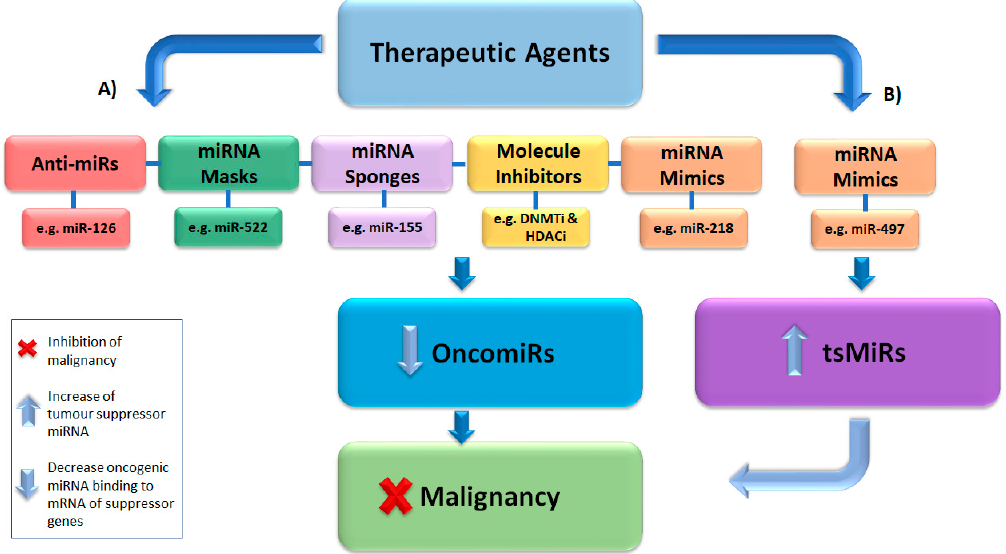
Figure 3. An overview of the therapeutic application of miRNA-based agents used in the prevention of tumour progression. These agents target and regulate the miRNA of interest, resulting in either inhibition of an OncomiR or upregulation of a tumour suppressor gene. Five commonly utilised therapeutic miRNA agents are displayed above showing ( A ) anti-miRs, miRNA sponges and miRNA masks used to suppress oncomiRs by inhibiting miRNA binding to mRNA. miRNA mimics and molecule inhibitor drugs can be used to inhibit DNMT enzymatic activity and trigger its degradation, thereby reducing oncomiR expression and development of malignancy. Similarly, histone deacetylase inhibitors (HDACis) can be used to block tumorigenesis. ( B ) miRNA mimics can also be utilised to mimic the activity of tumour suppressor miRNA in malignancies to reduce or suppress tumorigenesis.